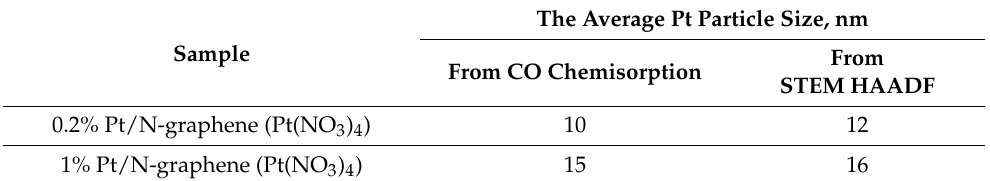
Table 1. Fraction of surface platinum atoms determined by CO chemisorption and STEM HAADF images. The Average Pt Particle Size, nm Sample